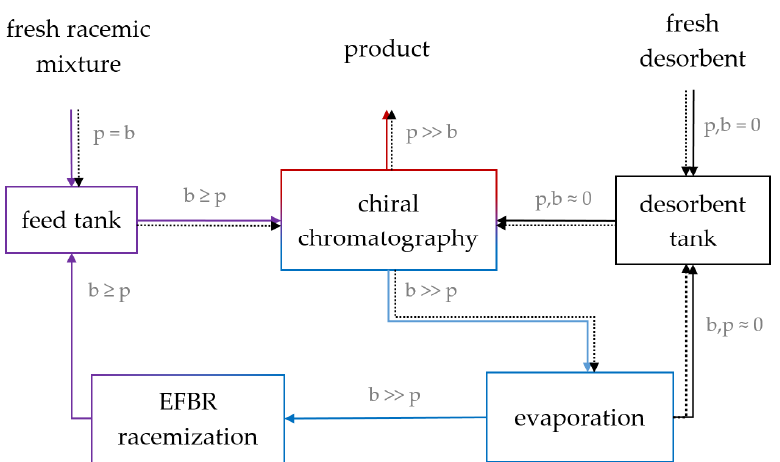
Figure 10. Process scheme of an integrated process including the chiral separation by chromatog- raphy, enzymatic racemization of the counter enantiomer in the EFBR, and solvent removal (SR) by evaporation for a concentration of the by-product stream. The solvents containing EtOH or MeOH are presented by additional dashed arrows.